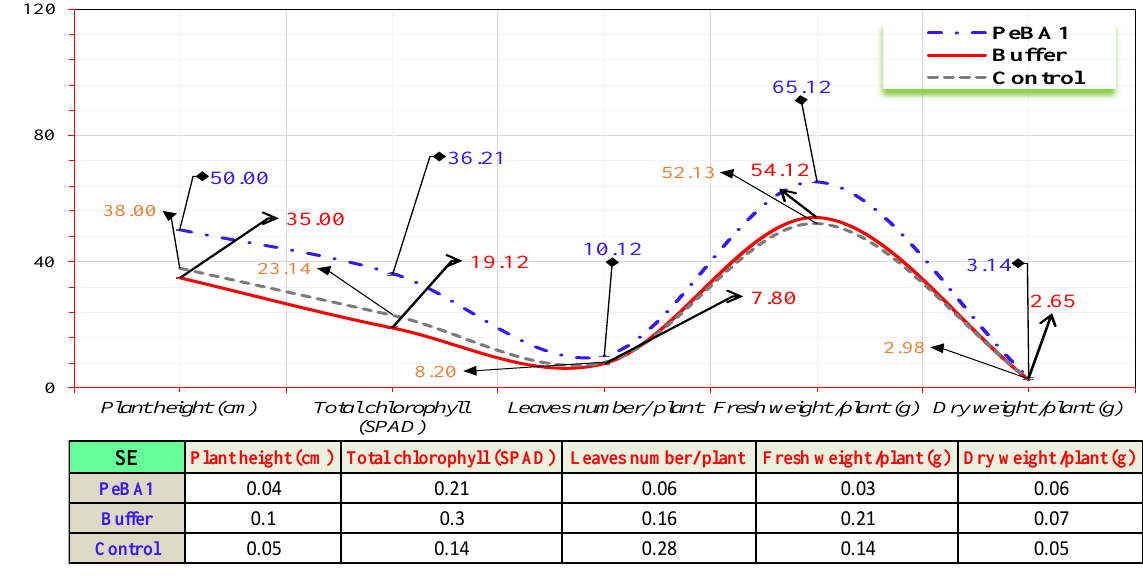
Figure 7. Effect of PeBA1 on growth of PeBA1-treated and control seedlings. Data shown in mean (±SD) of PeBA1, buffer, and control seedlings ( n = 10). The data were compared using LSD, one-way ANOVA, and Levene’s test in SPSS 18.0. ( p = 0.05).